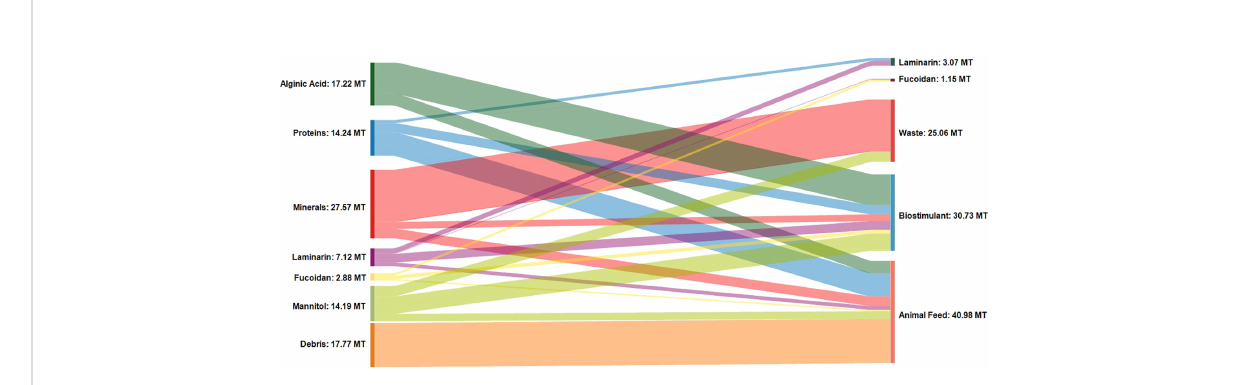
FIGURE 6 Sankey diagram for the raw material mass fl ow throughout the laminarin biore fi nery of S. latissima